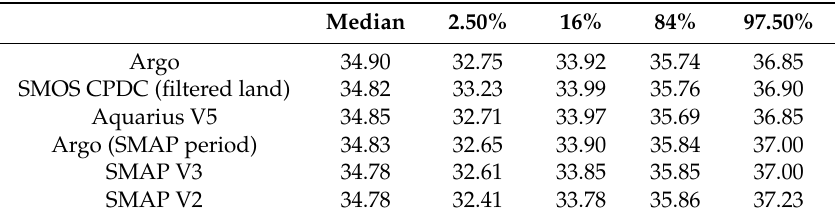
Table 3. SSS distribution statistics for satellite products and in situ observation from the Argo network (all values in psu). The SMOS, Aquarius and the top Argo row are computed for the Aquarius era (Sept 2011–May 2015), the second Argo row and SMAP results are computed during the SMAP